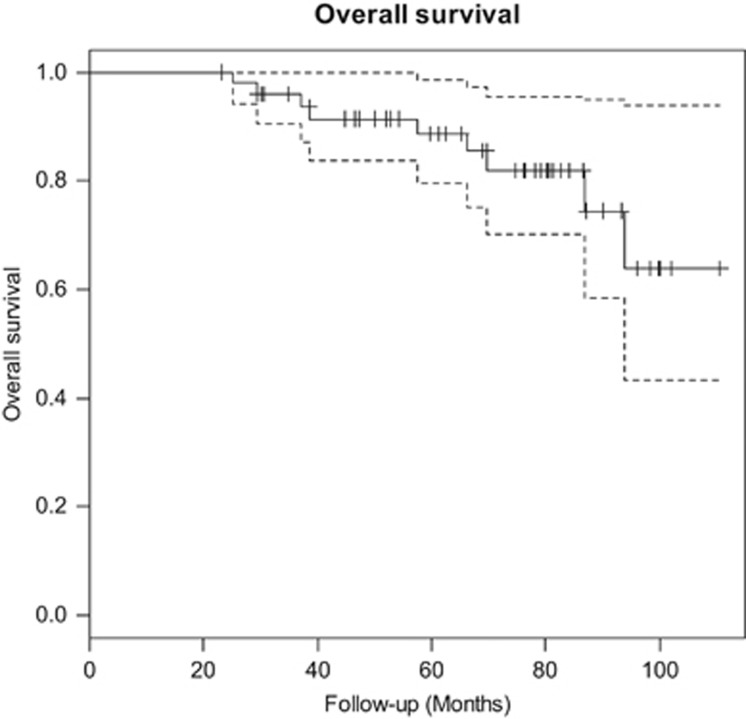
Overall survival for the whole cohort of 50 patients.